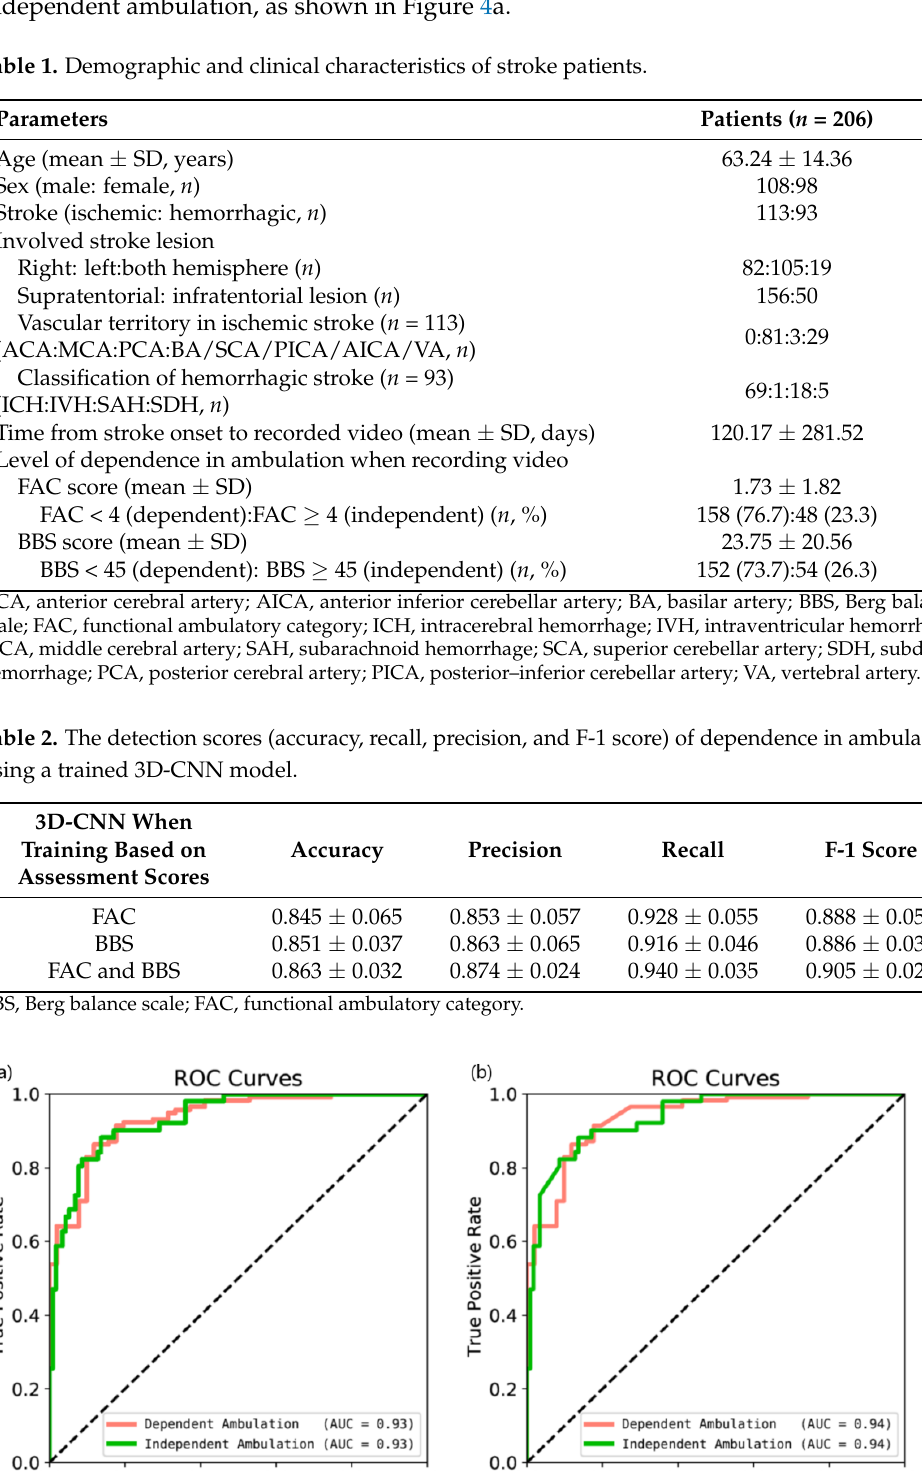
Figure 4. Receiver operating characteristic (ROC) curves for dependence in ambulation obtained: ( a ) using only the 3D-CNN and ( b ) when combined with measurement swing time asymmetry. The green line indicates independent ambulation following stroke and the pink line indicates dependent ambulation following stroke. AUC, the area under the curve.